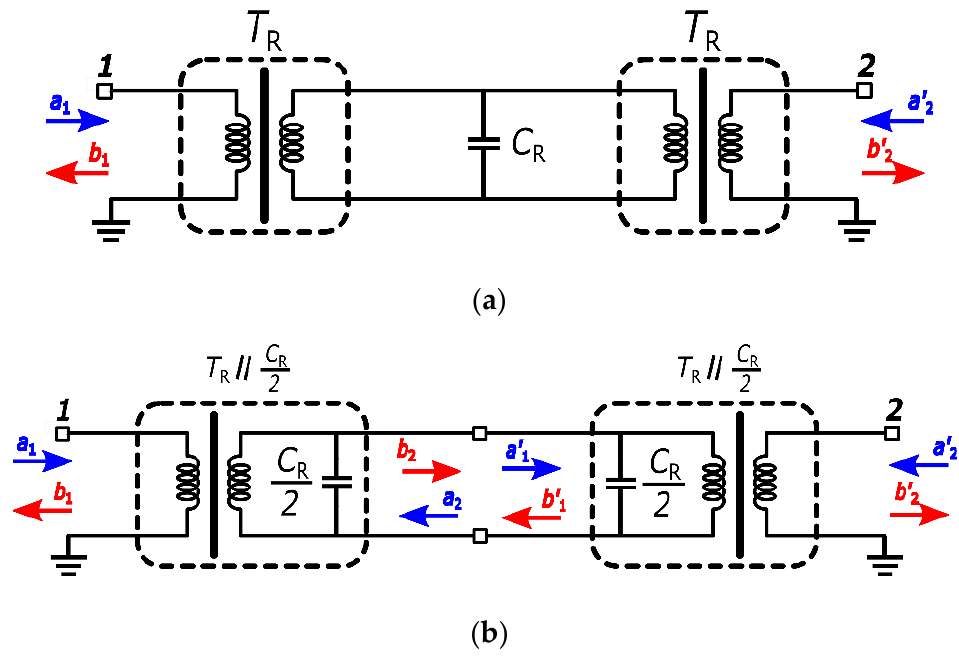
Figure A1. ( a ) Equivalent circuit of the transformer test structure in Figure 4a; ( b ) modified equivalent circuit of the transformer test structure in Figure 4a.